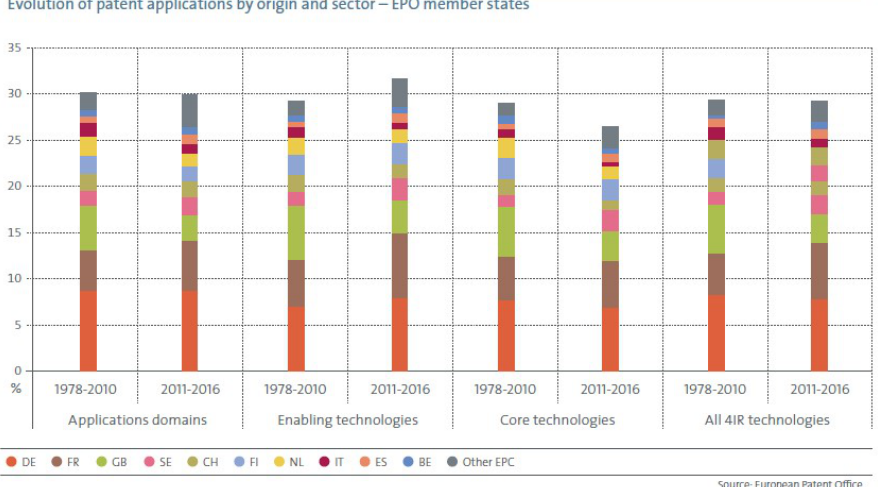
Figure 2. Contributions of each of the EPO member states to European participation in the application domains, and enabling and core technologies related to Industry 4.0 between 1978–2010 and